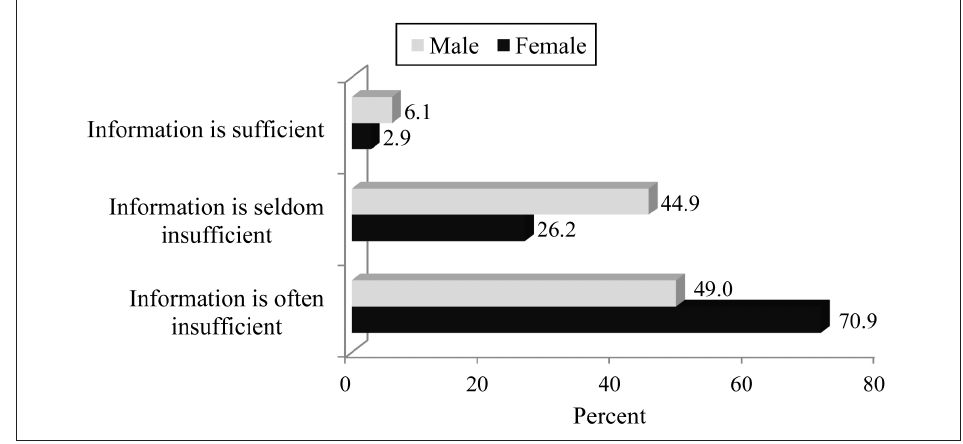
Figure 5. Students’ knowledge about physical activity